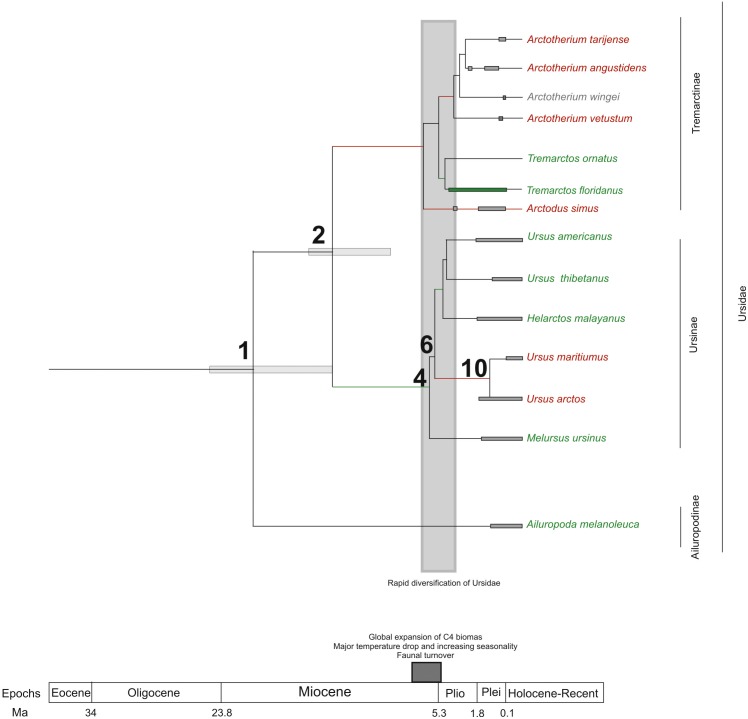
Cladogram in which habitat preferences where scored and optimized.Open habitat are in red lines, while closed habitats are in green lines (Modified from Krause et al., 2008).